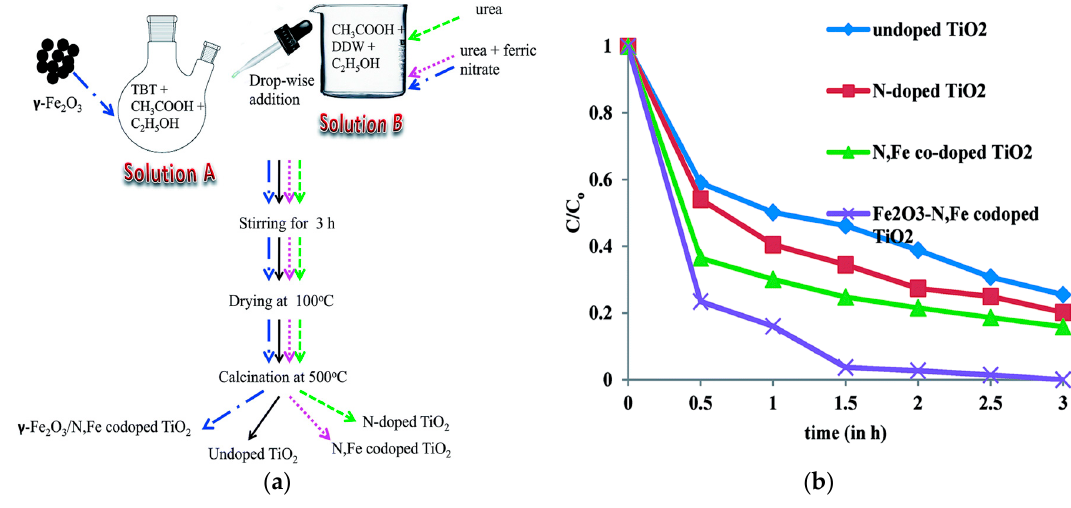
Figure 2. ( a ) Schematic illustration of the sol-gel preparation of γ -Fe 2 O 3 /N.Fe-TiO 2 ; and ( b ) photocatalytic degradation of RB 4 over γ -Fe 2 O 3 /N.Fe-TiO 2 and the controls. Reproduced with permission from [111]. Copyright 2015, RSC.